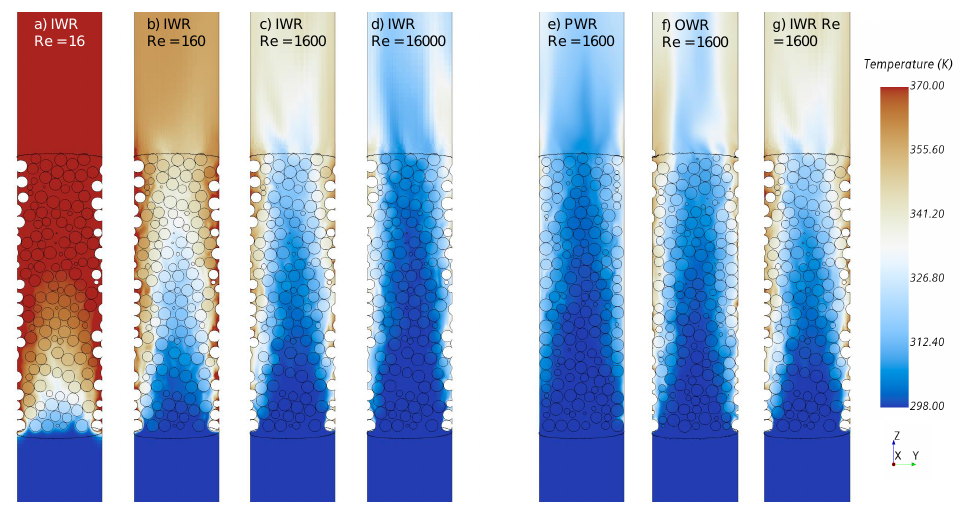
Figure 14. Comparison of the temperature distribution in a cross section through the center axis of the reactor.